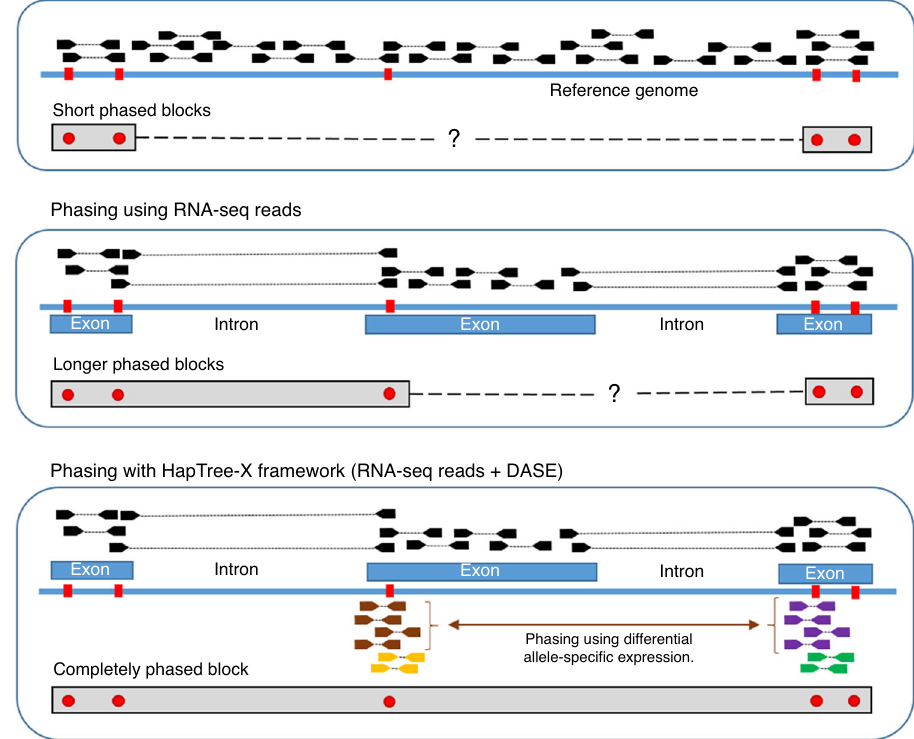
Fig. 1 HapTree-X framework compared to read-based phasing. Traditional whole-genome sequencing (WGS) based phasing methods (top panel) depend on sequence contiguity and thus require a pair of SNPs (in red) to be connected through a common read that overlaps both in order to be phased. RNA-seq reads provide longer distance phasing capability due to long introns in the genome that are spliced-out in the sequenced transcript fragments (middle panel), yet SNPs that are far apart within the transcript due to long homozygous exonic regions are still dif fi cult to phase using RNA-seq reads. Our HapTree-X framework (lower panel) overcomes this limitation by integrating RNA-seq reads and differential allele-speci fi c expression (DASE) available from the RNA-seq data into a single probabilistic framework for haplotype phasing. For genes that display differential haplotypic expression (DHE), the majority of alleles can be phased together to obtain a single haplotype block for the entire gene. Depending on the DHE and depth-coverage, DASE-based phasing performs accurate haplotype reconstruction, without requiring paired-end or long reads, maintaining or improving on accuracy independent of gene/exon lengths as long as differential haplotypic expression is consistent across the loci being